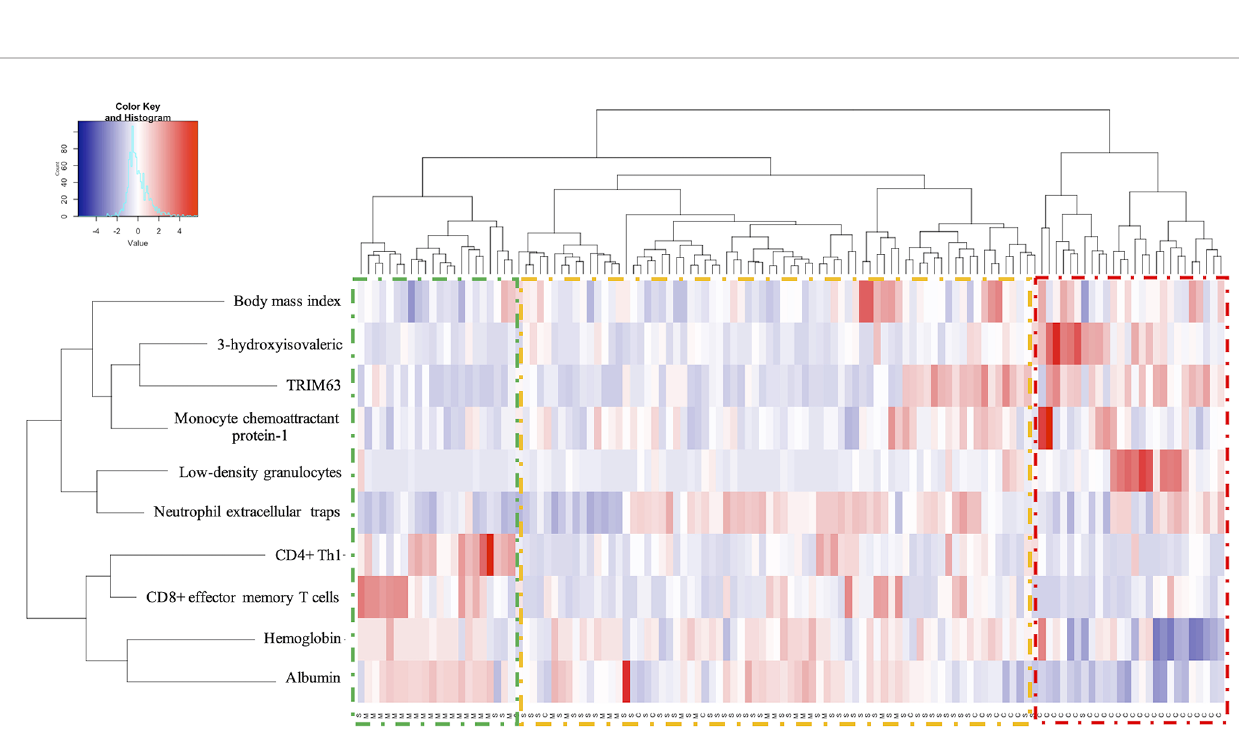
FIGURE 2 | Heat map from clustering analysis for COVID-19 severity according-the predictive variables. Hierarchical clustering analysis generated by Ward´s method relating mild/moderate (M, green), severe (S, yellow) and critical (C,